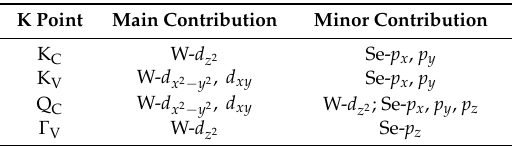
Figure 4. Total and projected density of states (TDOS and PDOS) of monolayer WSe 2 calculated by hybrid density functional calculations/CRYSTAL14 (HSE06/CRY14). The grey area represents the TDOS. In ( a ), blue and red lines represent PDOS on 4 p and 5 d states of Se and W; In ( b ), black, blue, green and red lines represent PDOS on 5 d , d z 2 , d xz + d yz and d xy + d x 2 − y 2 , respectively. The Fermi level is scaled to zero (the top of valence band). Table 1. Contribution of atomic orbitals to the valence band maximum (VBM) and to the conduction band minimum (CBM) states projected on different k-points calculated with HSE06/CRY14. K Point Main